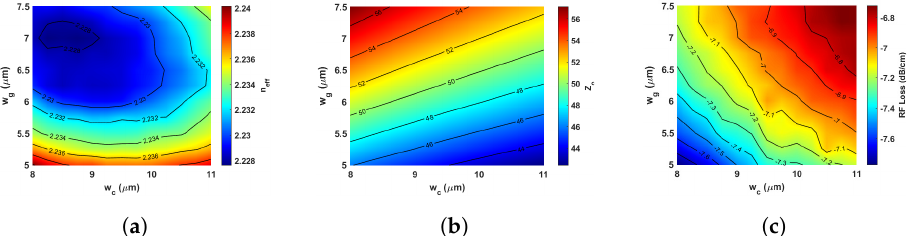
Figure 2. Color maps of ( a ) n eff , ( b ) Z o and ( c ) RF losses for varying w c and w g at t Au = 0.5 µ m and h clad = 2.75 µ